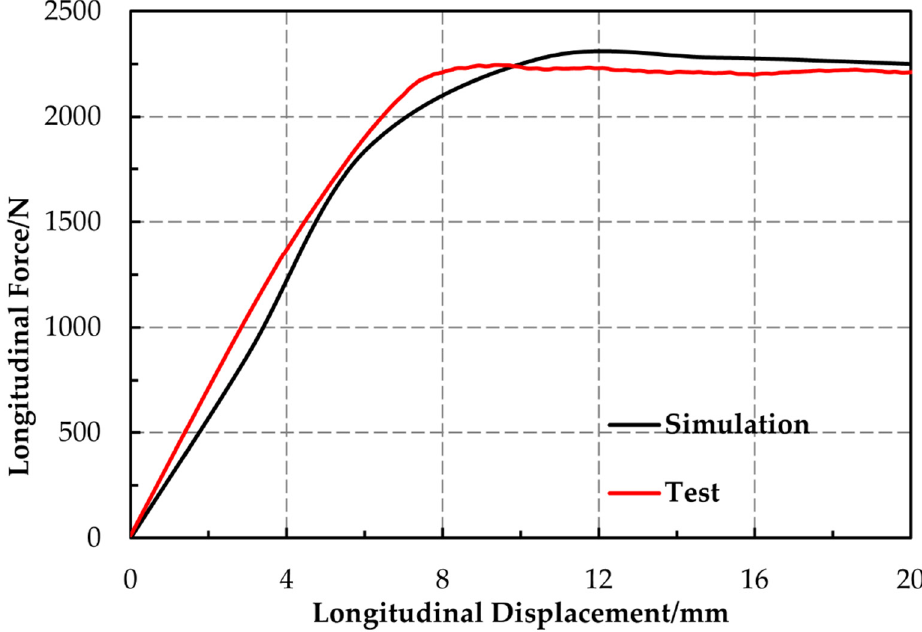
Figure 8. The courses of the center lines of the longitudinal stiffness in the test and simulation.